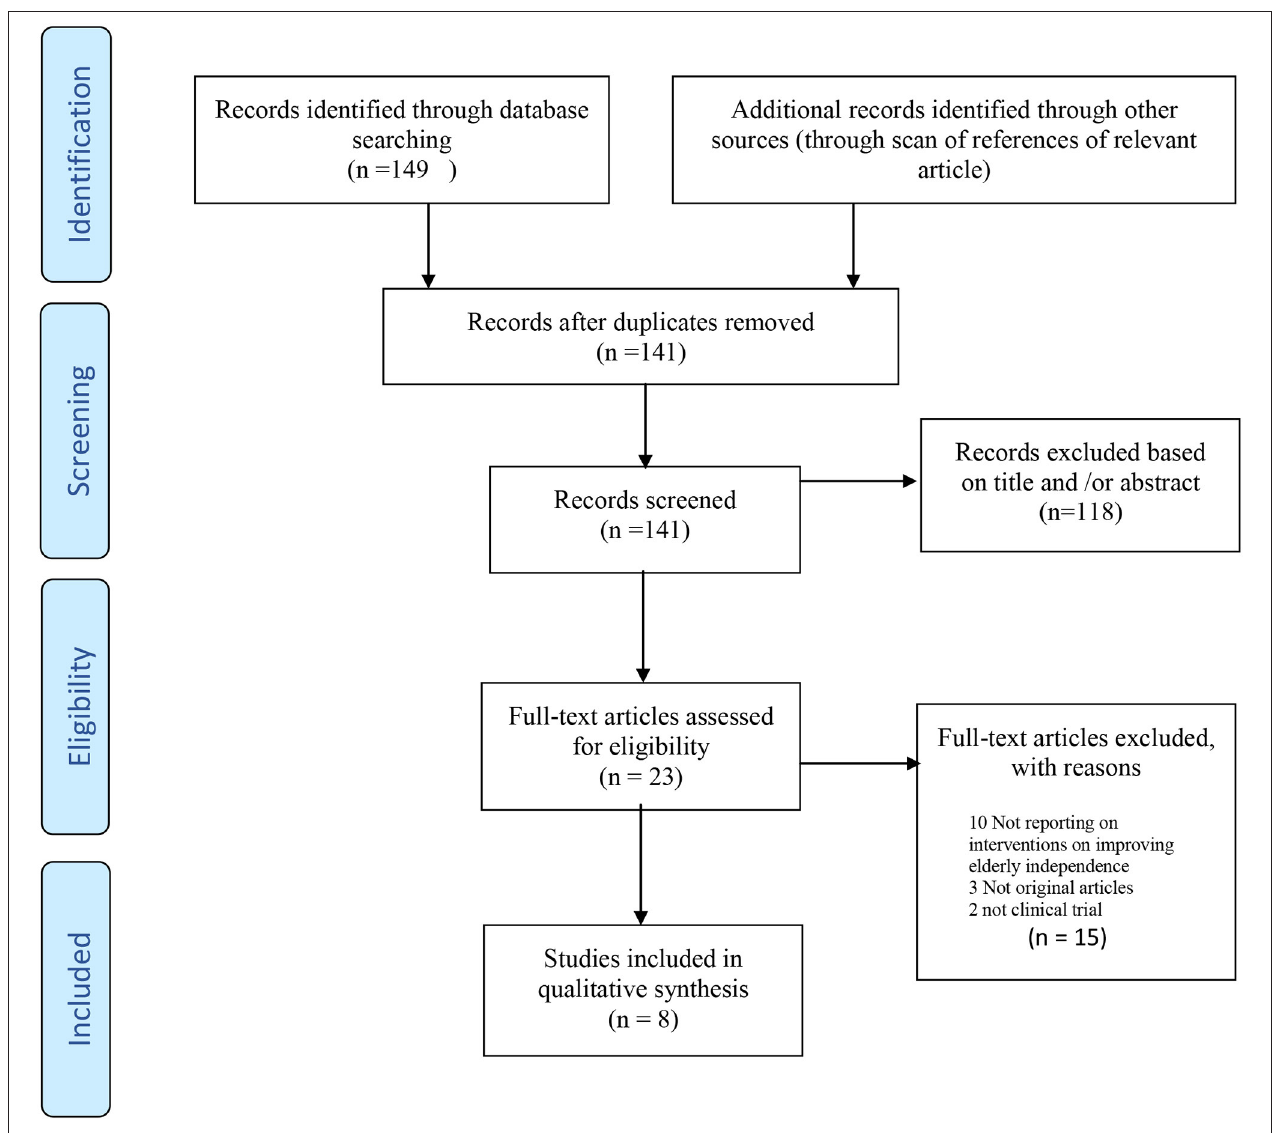
FIGURE 3 | Search process and study identification systematic review of studies with a theoretical framework during interventions for improving elderly’s independence in